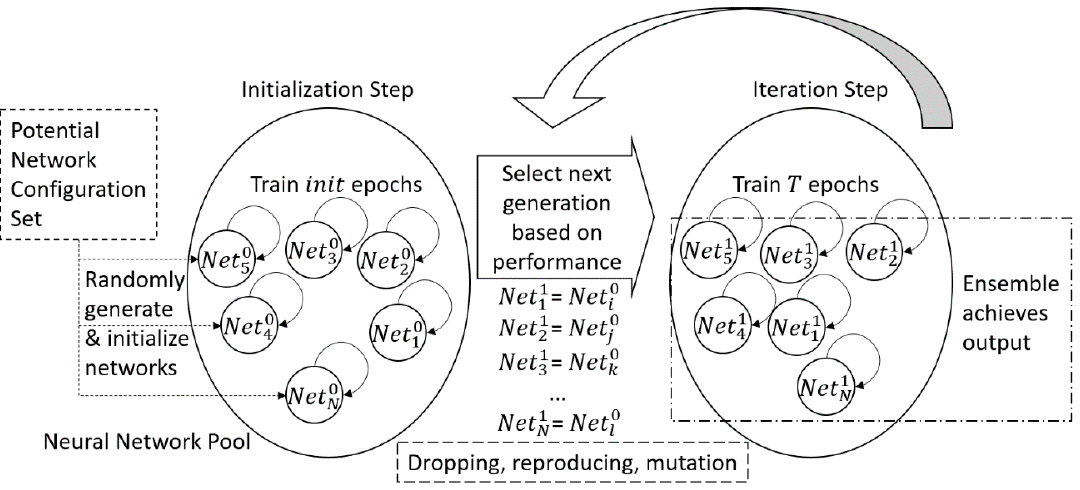
Figure 2. An overview of the proposed method.